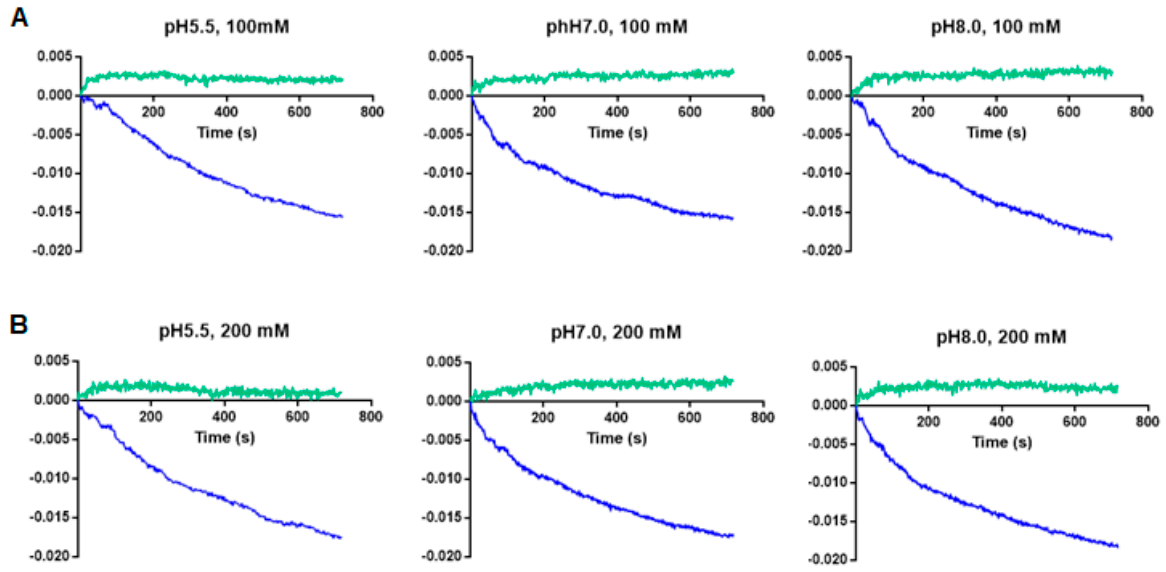
Figure 7. The NaCl diffusion assays performed using the proteoliposomes constituted with the ECH_0379 recombinant protein in lipid vesicles. The diffusion rates were measured by monitoring the decrease in OD 400 nm absorbance in the presence of NaCl at 100 mM ( A ) or 200 mM ( B ) concentrations and at three different pH conditions. Blue and green lines represent liposomes prepared with and without the purified ECH_0379 recombinant protein, respectively. The data represent the average values from three independent experiments.